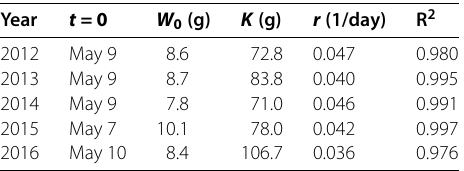
Table 1 The initial time t = 0, the identified W 0 , K , and r , and R 2 value between the measured and identified W t in each